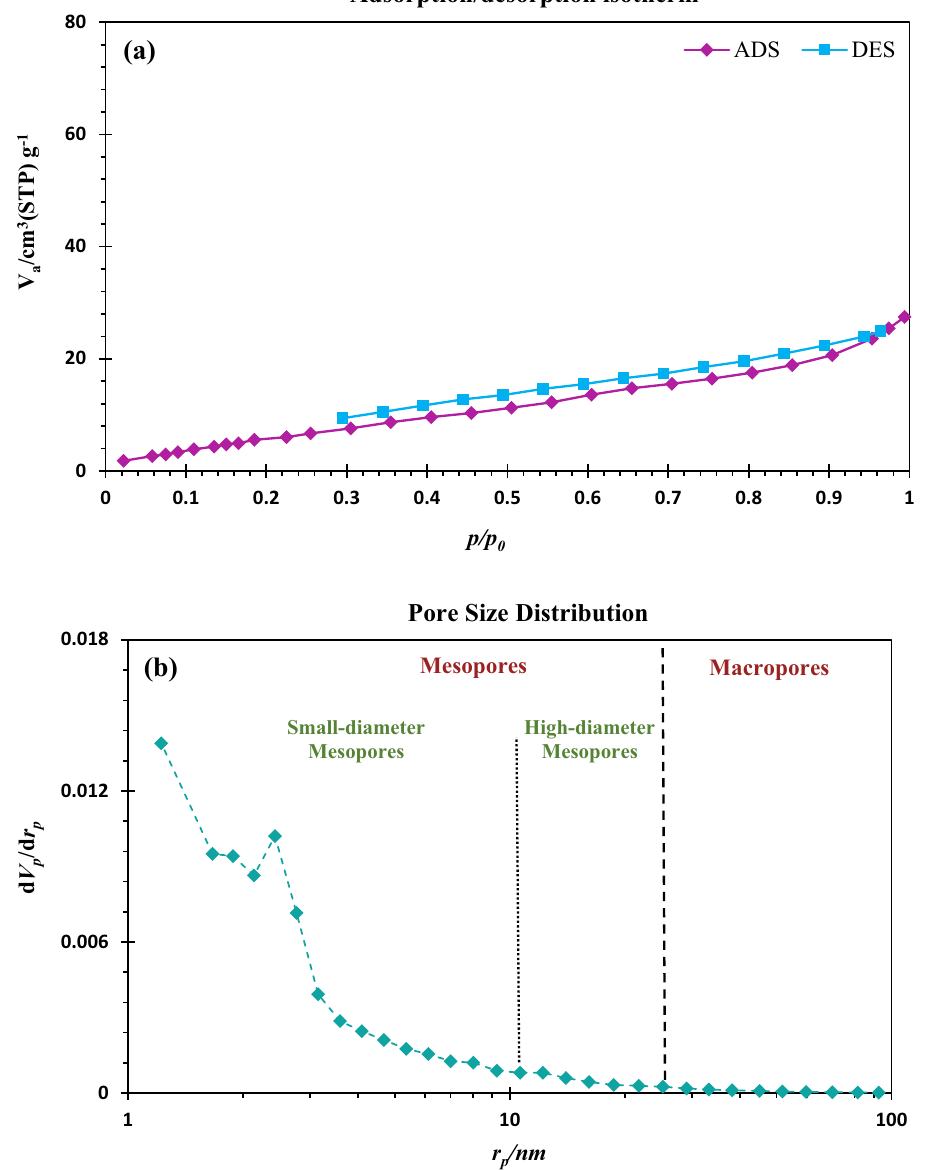
Figure 9. ( a ) N 2 adsorption/desorption isotherm, ( b ) pore size distribution curve of CuFe 2 O 4 /CQD